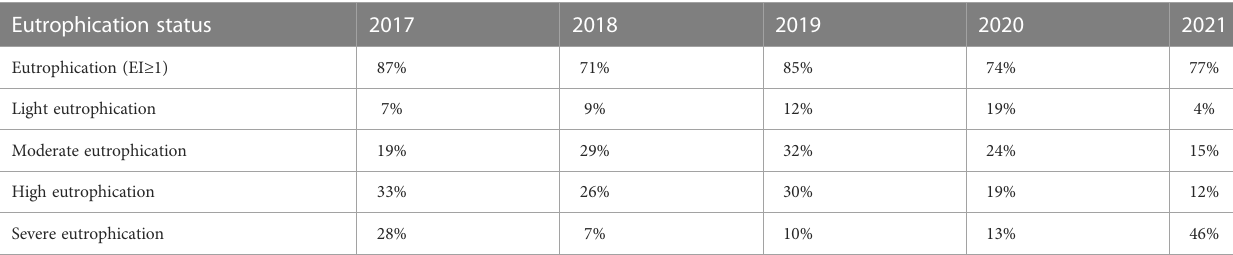
TABLE 1 Contribution of different eutrophication status in Zhanjiang Bay during 2017-2021.